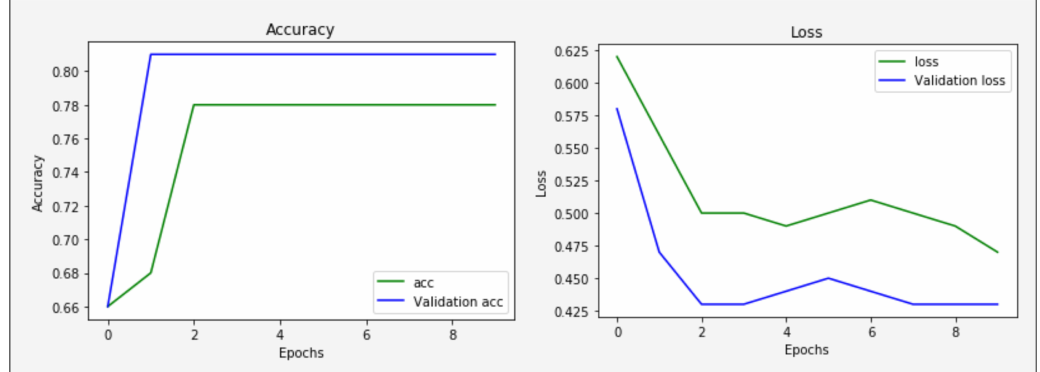
Figure 8. Validation accuracy and loss during the training of the RNN model.